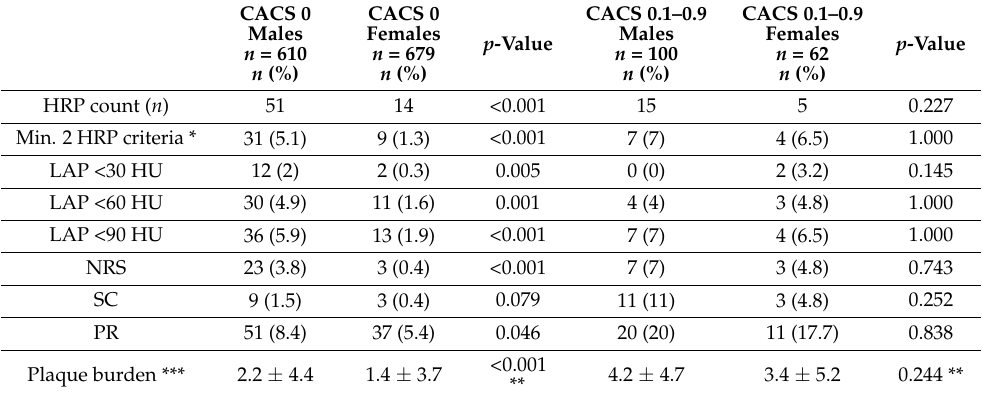
Table 4. High-risk plaque (HRP) criteria and plaque burden by coronary CTA before propensity score matching ( n =